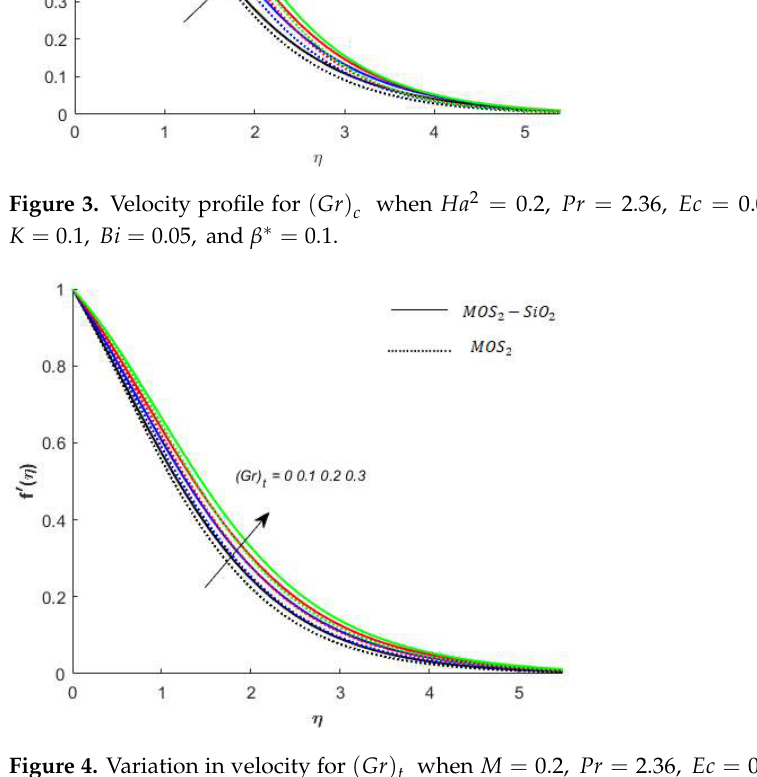
Figure 5. Variation in velocity for 𝐾 when 𝐻𝑎 (cid:2870) = 0.2,𝑃𝑟 = 2.36,𝐸𝑐 = 0.01,𝑆𝑐 = 0.8,𝑆𝑟 = 0.1,𝐵𝑖 = 0.05,and 𝛽 ∗ = 0.1 . Figure 6. Variation in velocity for 𝛽 when 𝑃𝑟 = 2.36,𝐸𝑐 = 0.01,𝑆𝑐 = 0.8,𝑆𝑟 = 0.1,𝐵𝑖 = 0.05, and 𝛽 ∗ = 0.1.